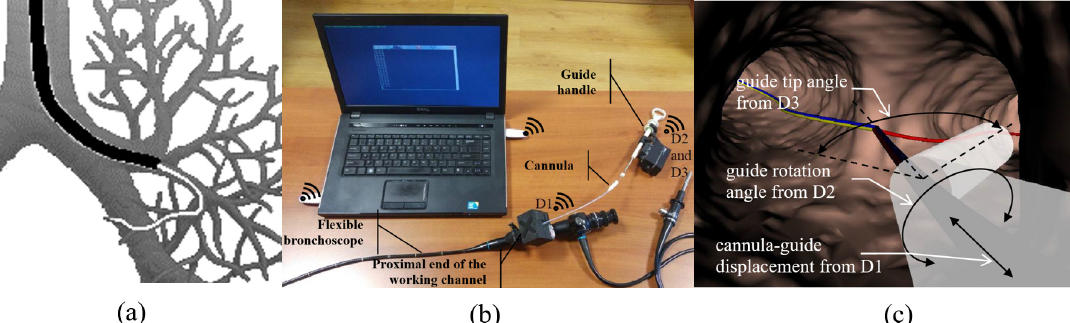
Figure 1. The problem of navigation inside the bronchial tree and its solution. ( a ) The problem of maneuvering the guide in order to reach the designated place in the deep part of the bronchial tree. ( b ) Full measurement system prototype. ( c ) Virtual animated guide tip (transparent white element) in the virtual bronchoscopy space.